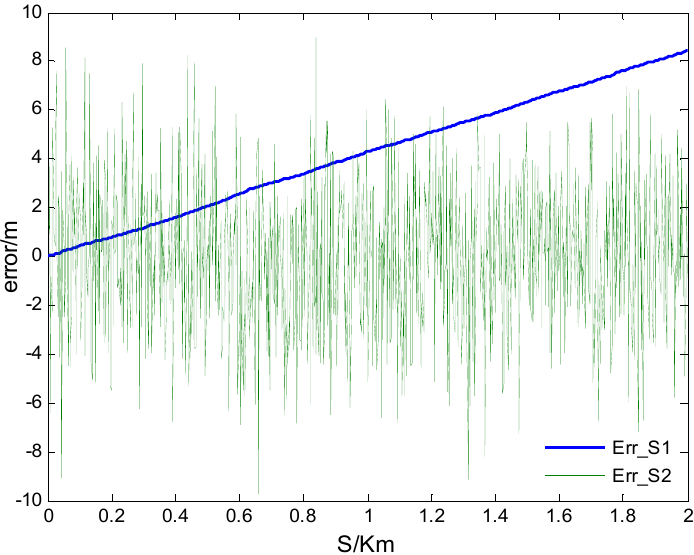
Figure 4. GPS calculated distance errors varies with travel length